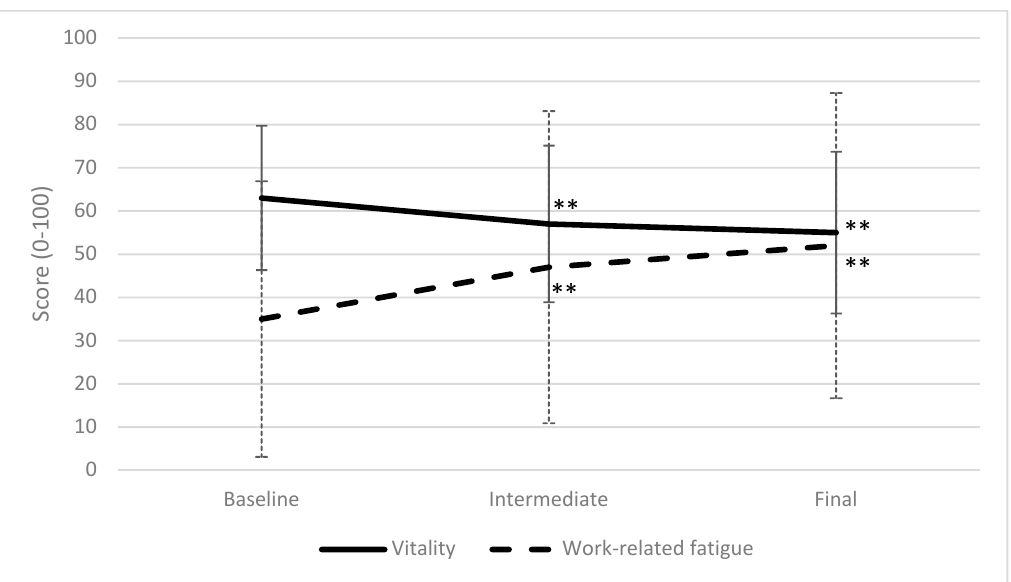
Figure 2. Trajectory of general, physical, and mental work ability during the peak season. Mean and SD are shown with error bars. A score of 0 stands for no work ability at all, and 10 corresponds to the best work ability ever experienced. Values with * or ** showed significant changes compared to baseline measurements: * p < 0.05, ** p < 0.01.